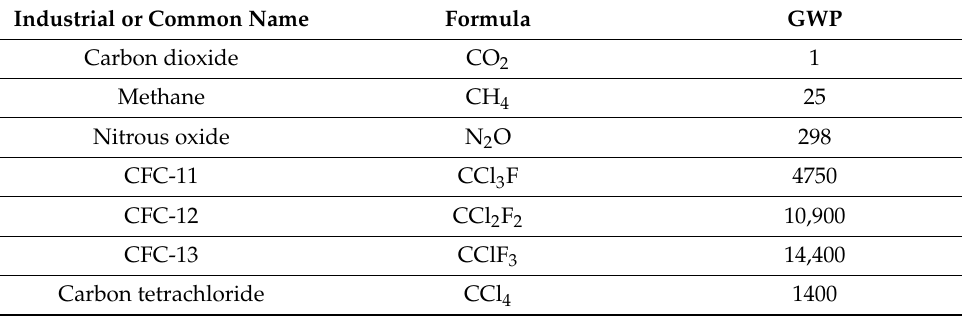
Table 1. Global warming potentials (GWPs) relative to CO 2